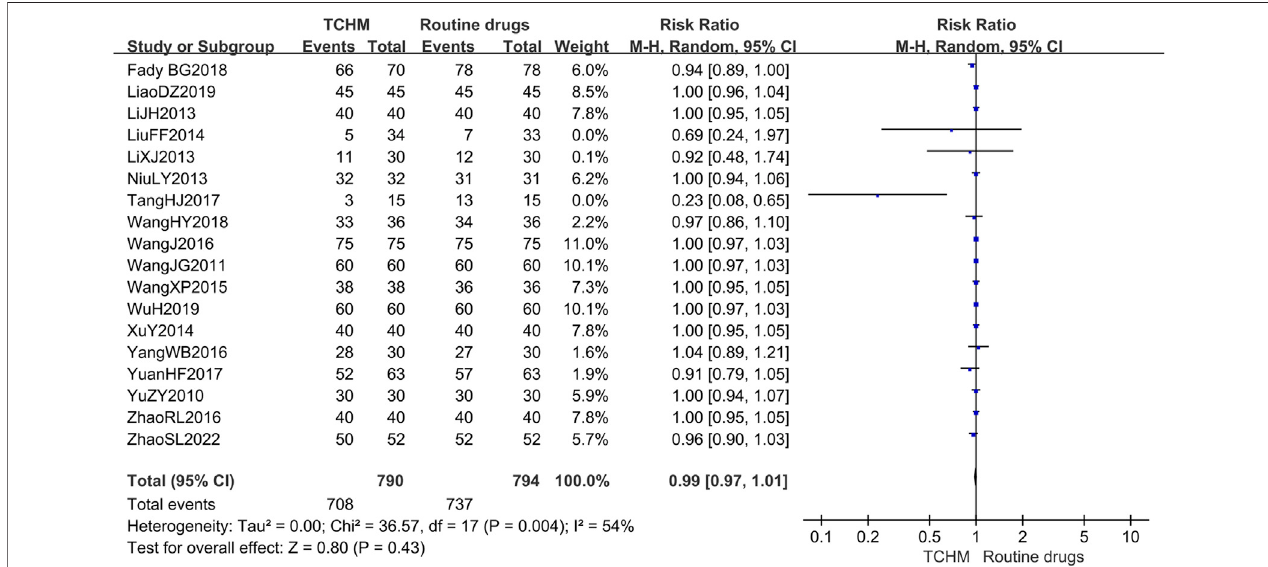
FIGURE 5 | Forest plot and pooled risk ratios for association of incidence rate of radiodermatitis with TCHM and routine drugs.